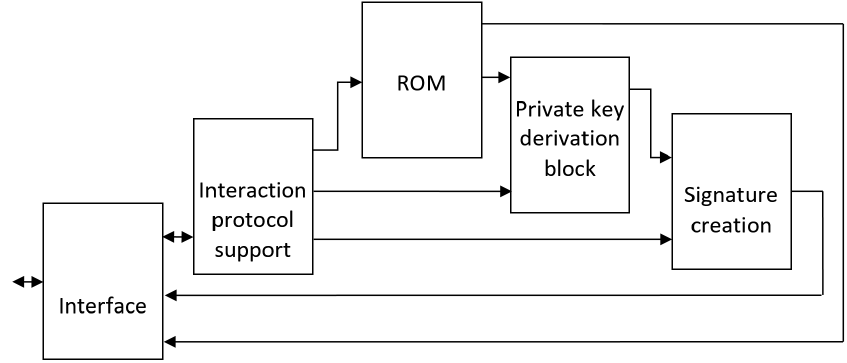
Figure 3. Generalized structure of ID-card